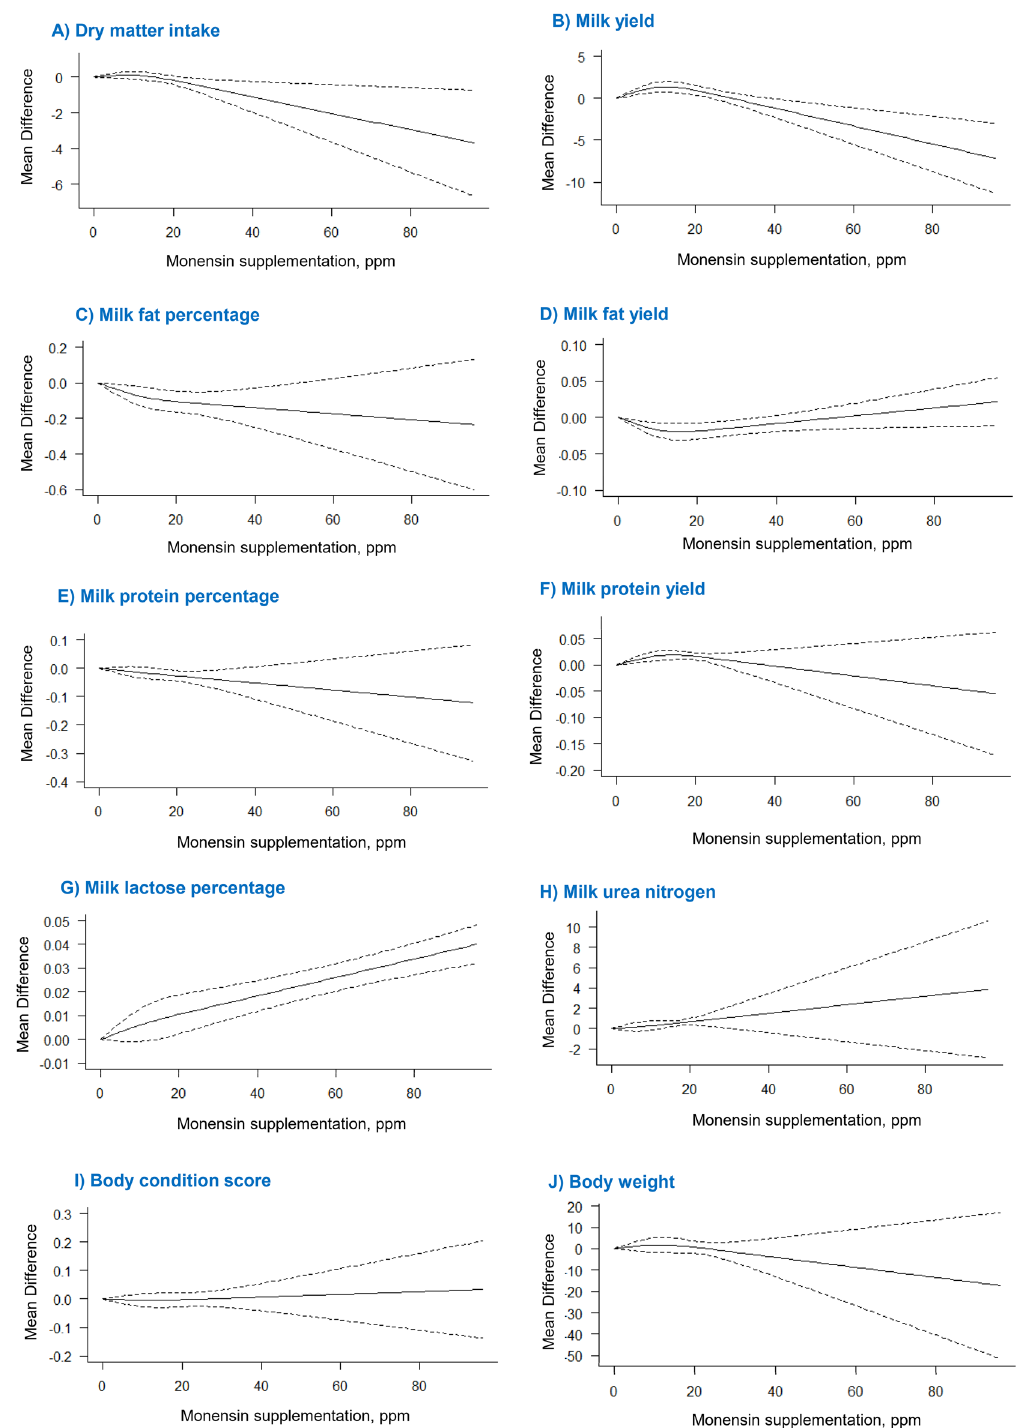
Figure 3. Dose–response association between monensin supplementation and ( A ) dry matter intake (kg/day), ( B ) milk yield (kg/day), ( C ) milk fat percentage, ( D ) milk fat yield (kg/day), ( E ) milk protein percentage, ( F ) milk protein yield (kg/day), ( I ) milk lactose percentage, ( G ) milk urea nitrogen (mg/dL), ( K ) body condition score, and ( L ) body weight (kg). The solid line and the dashed lines represent the estimated mean difference and its 95% confidence